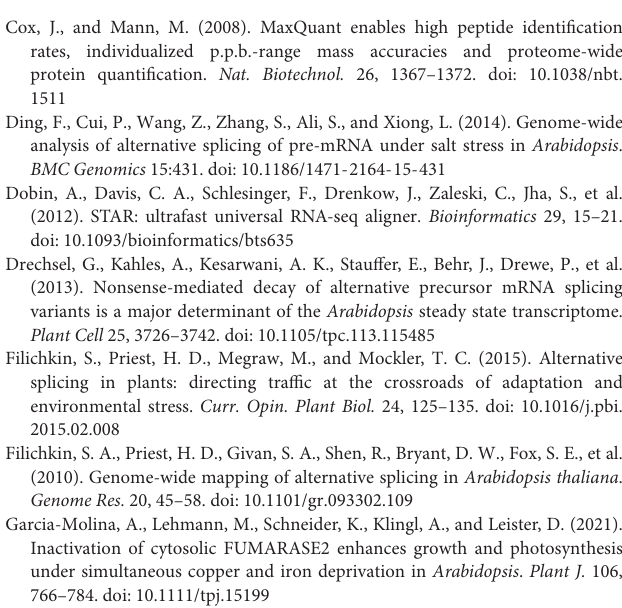
Supplementary Figure 1 | Analysis of differential splicing events under individual and simultaneous deficiency of copper and iron. Venn diagrams for multiple comparisons among differentially splicing events per treatment according to an absolute fold-change of at least 2 in pair-wise comparisons (adjusted- p -value ≤ 0.05, two-way ANOVA with post hoc Tukey’s test). Supplementary Figure 2 | Primary analysis of intron retention in transcripts involved in tryptophan and asparagine biosynthesis under single and simultaneous copper and iron deficiency. The average of read counts per exon or intron bins for the selected genes under standard conditions (Cont) and single and double copper and iron deficiencies (–Cu, –Fe, and –Cu–Fe) was calculated using the ASpli package. Bars represent the percentage of reads detected in intronic bins over the total reads in the whole genic region (introns plus exons